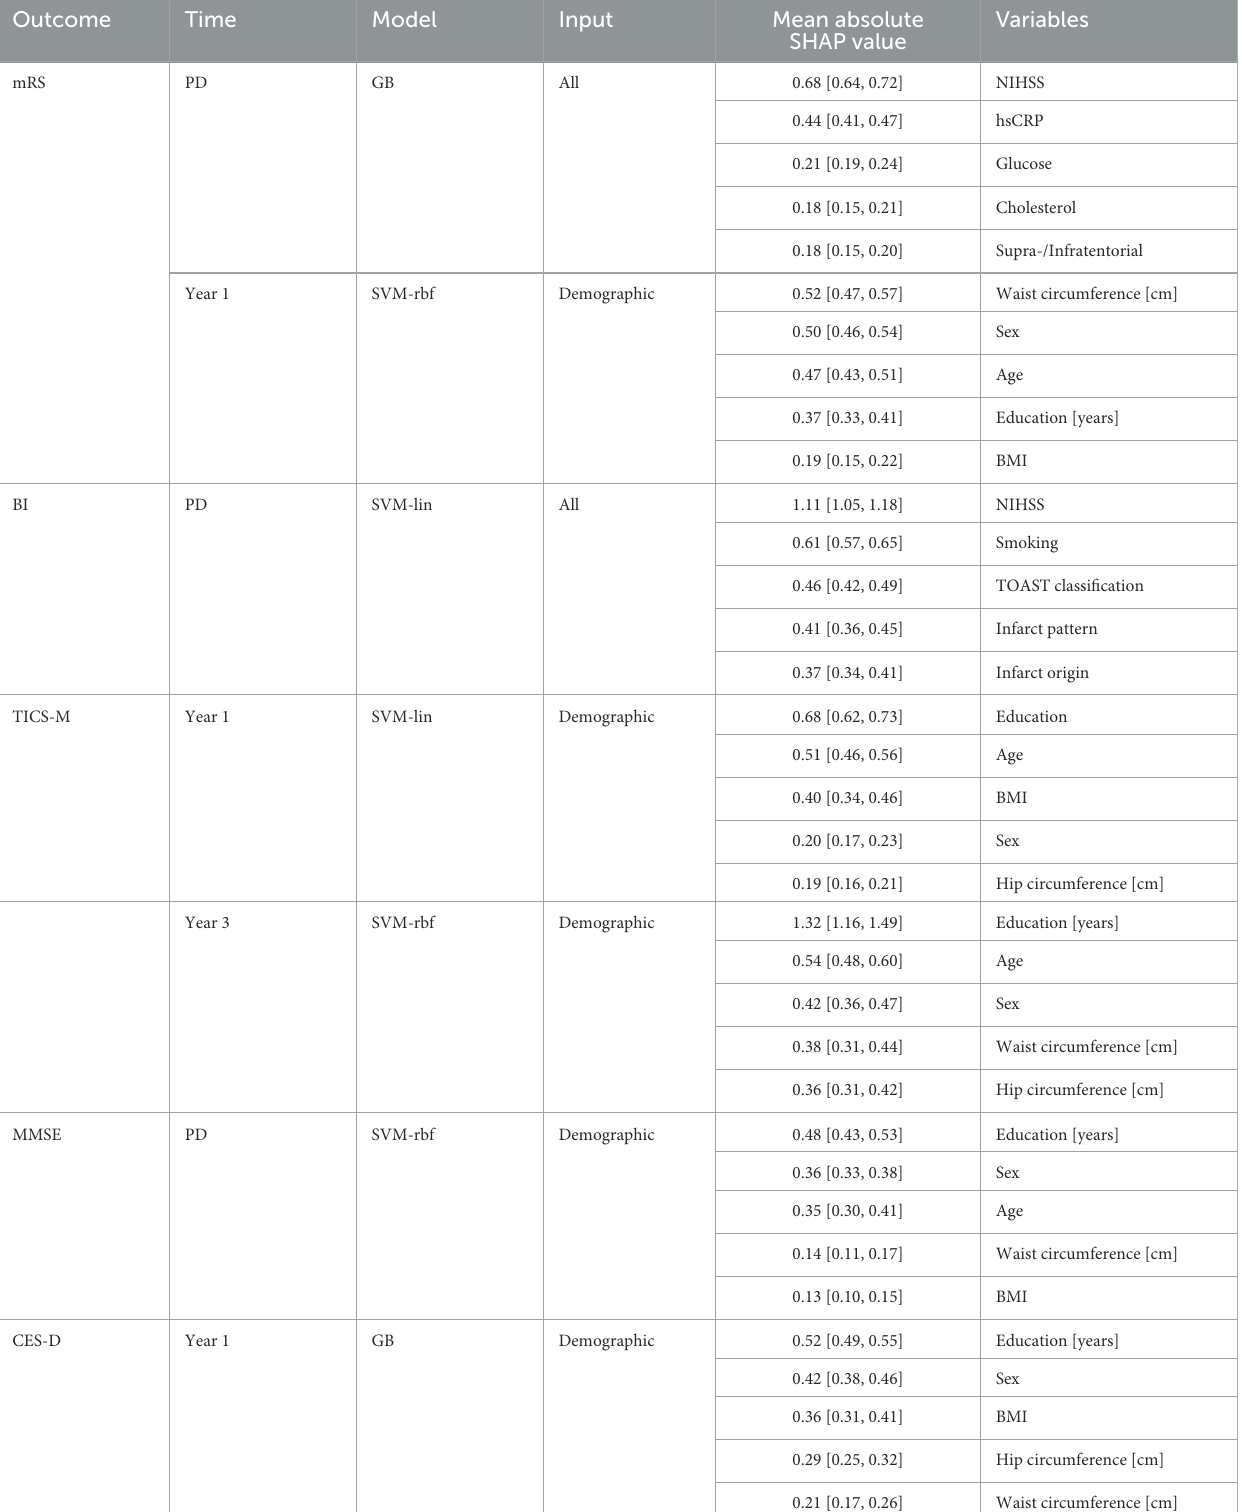
TABLE 3 Best prediction results and most important predictors for all outcomes as determined via Shapley values.